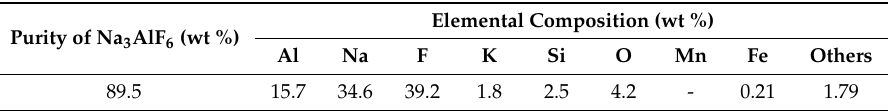
Table 3. Purity of Na 3 AlF 6 .